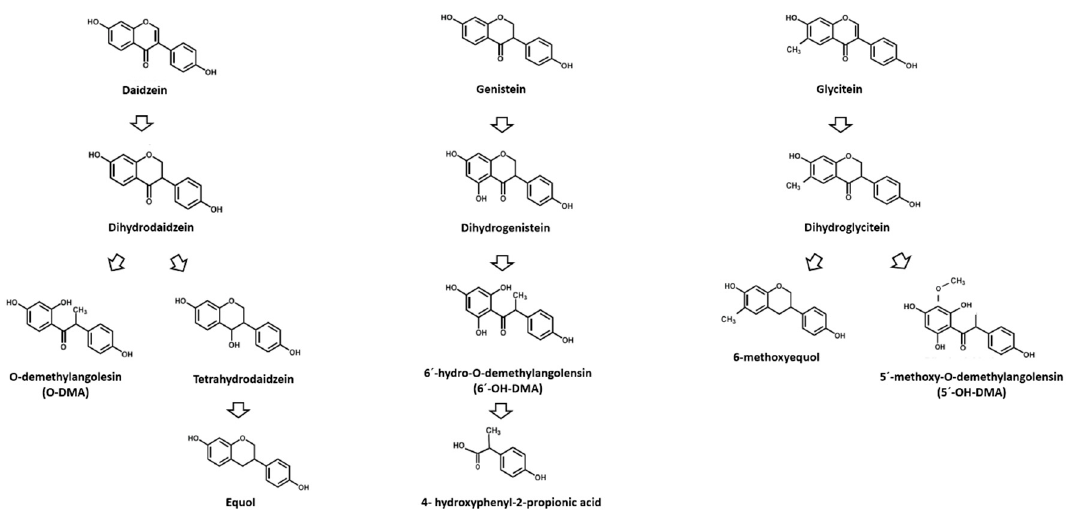
Figure 3. Bacterial metabolites of isoflavones forming in the gut. Modified from Mace et al. and Rossi et al. [12,42].